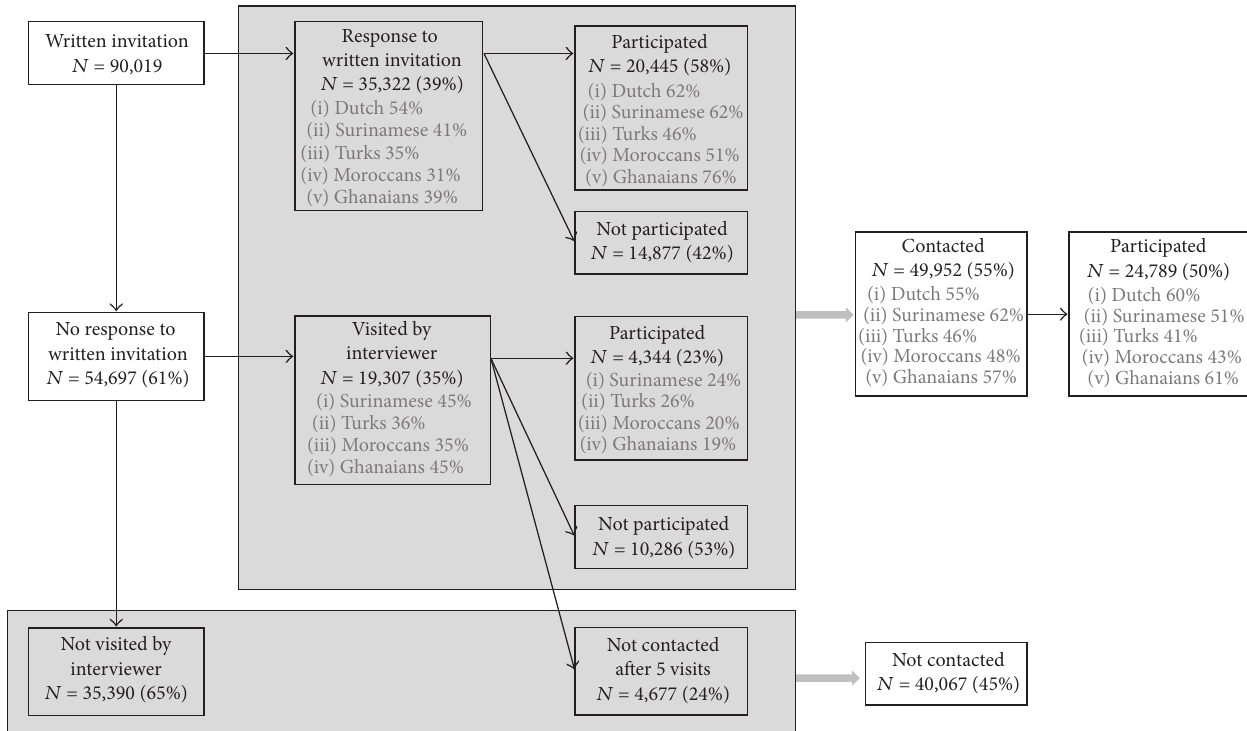
Figure 1: Flowchart of recruitment for the HELIUS